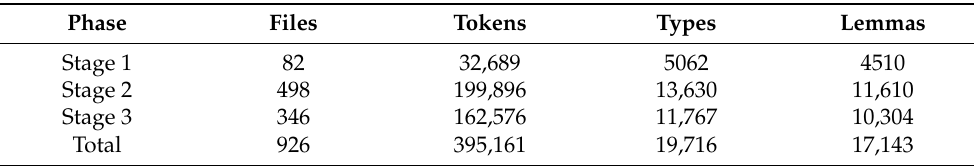
Table 3. The specific descriptions of the three